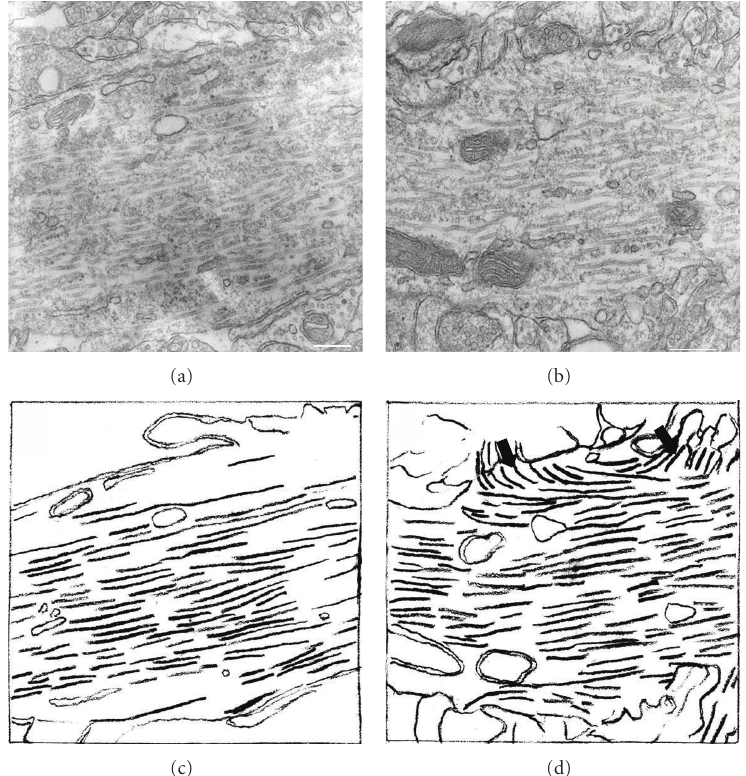
Figure 1: Redistribution of microtubules in dendritic shafts of hippocampal CA1 neurons after tetanic stimulation during LTP. A relatively small dendrite (about 1200 nm in diameter) of CA1 neurons in a nonstimulated hippocampal slice (a) and (c). Similar size of dendrite of CA1 neurons in a stimulated hippocampal slice (b) and (d). Many subcortical microtubules which went in the direction of spines emerged after stimulation (arrows in (d)). Reprinted from Mitsuyama et al. (2008) [21] with permission. Bar, 200 nm.